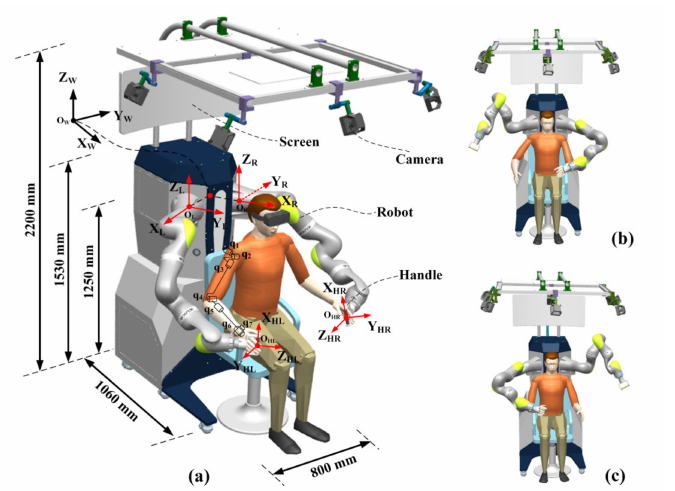
Figure 2. The three-dimensional model of the rehabilitation robot. ( a ) is the overview of the rehabili- tation robot; ( b ) is the unilateral rehabilitation training schematic of the left arm; ( c ) is the unilateral rehabilitation training schematic of the right